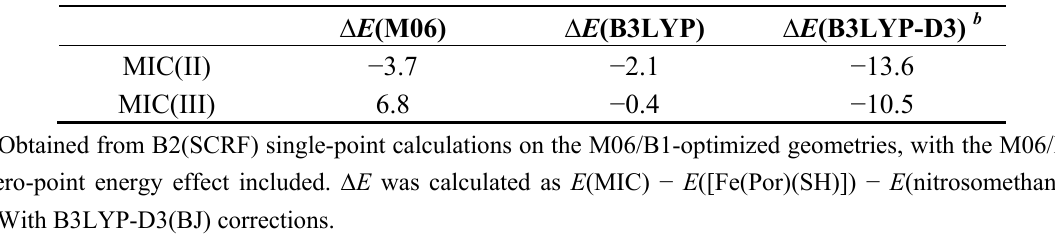
Table 1. Interaction energies (kcal/mol) calculated for the MIC(II) and MIC(III) a